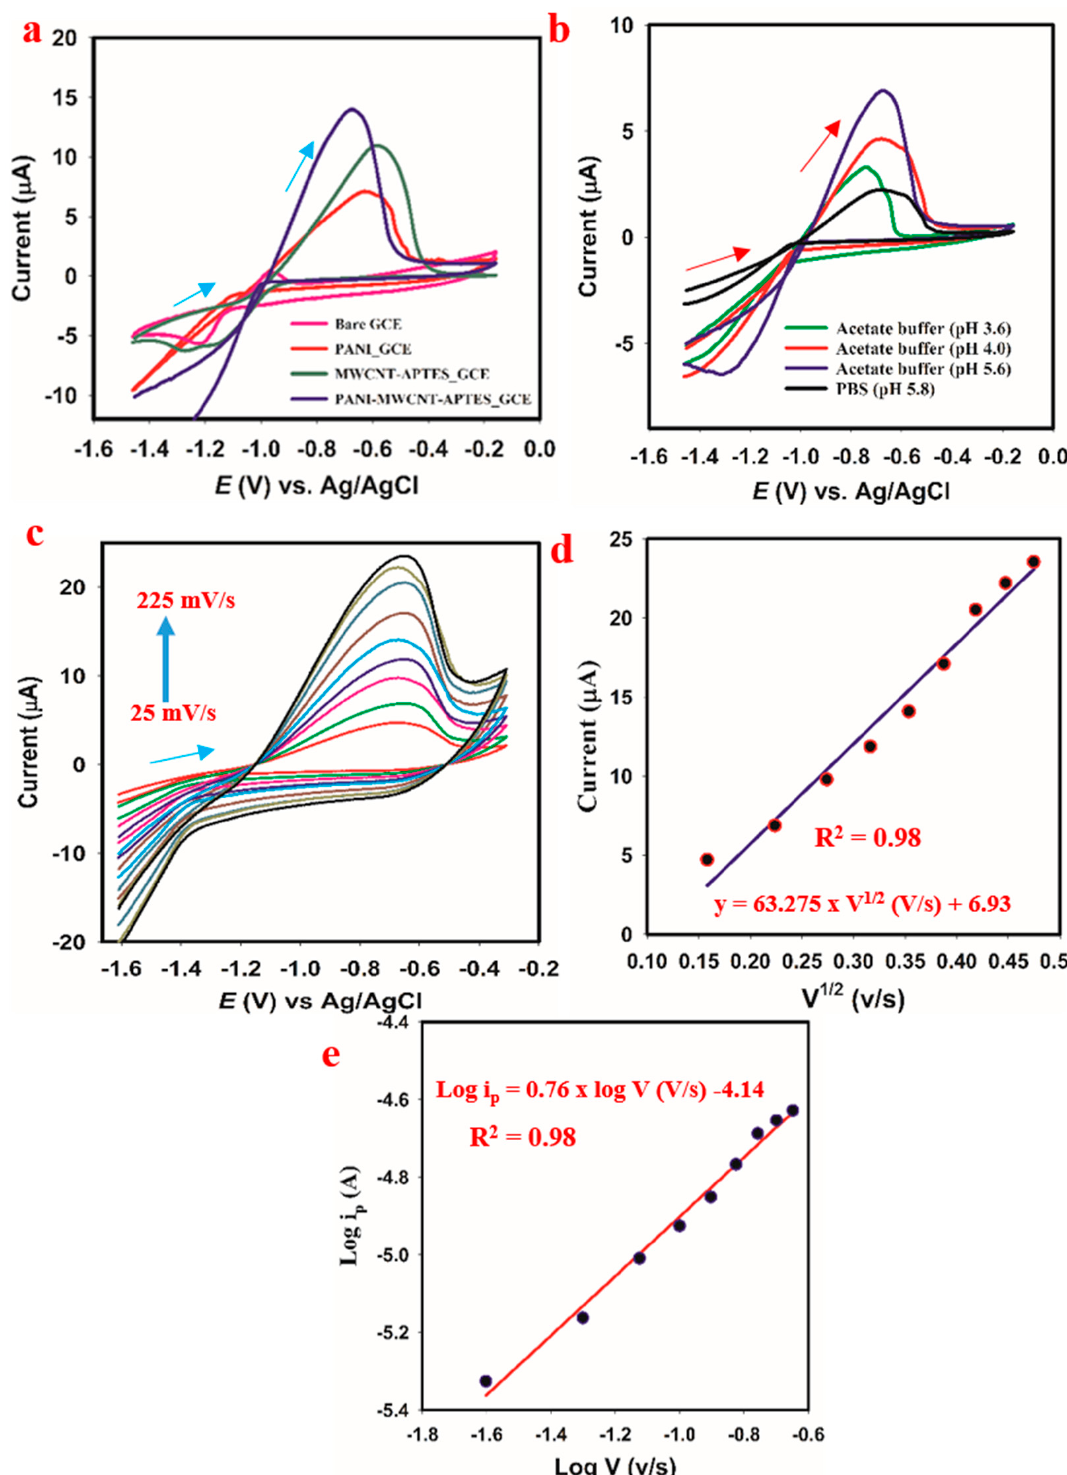
Figure 5. Electrochemical sensing responses: ( a ) effect of pH medium on the reduction in the current response exhibited by PANI-MWCNT-APTES in 15 µM CdSO 4 . ( b ) Control study in 50 µM CdSO 4 . ( c ) The obtained CV upon variation of the scan rate in 30 µM CdSO 4 ( d ) Linear plot of the scan rate variation against current. ( e ) Linear plot of the logarithm for a reduction in current versus the logarithm of the scan rate.